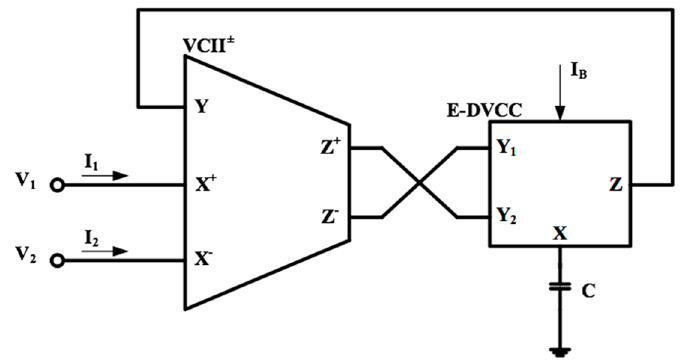
Figure 2. The proposed floating negative capacitance multiplier.